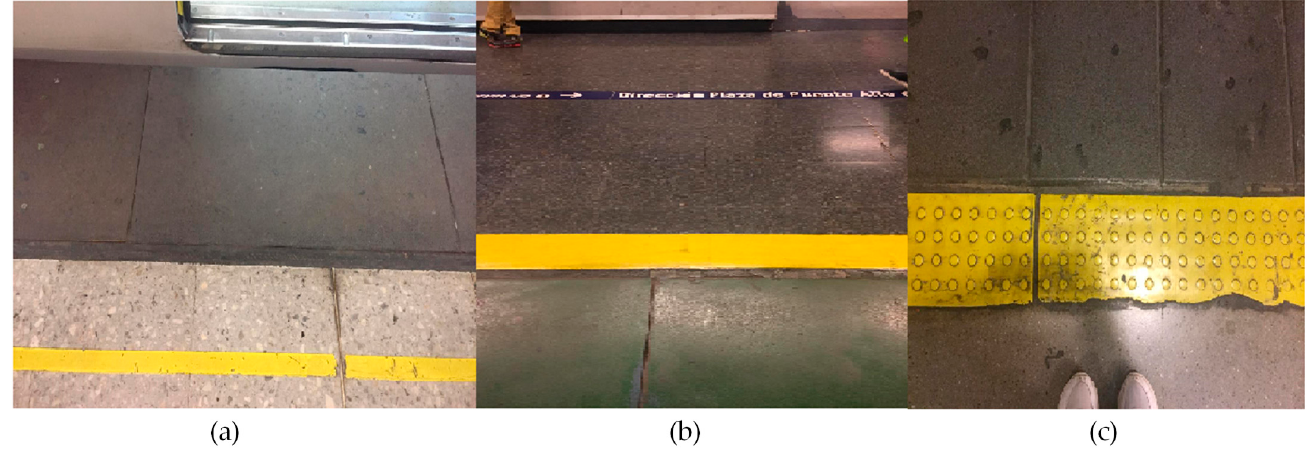
Figure 1. Yellow-safety-line designs in metro stations in Line 1 of the Santiago Metro, Chile: ( a ) 5 cm yellow adhesive tape, ( b ) 10 cm yellow adhesive tape, and ( c ) 24 cm PVC with yellow pods.